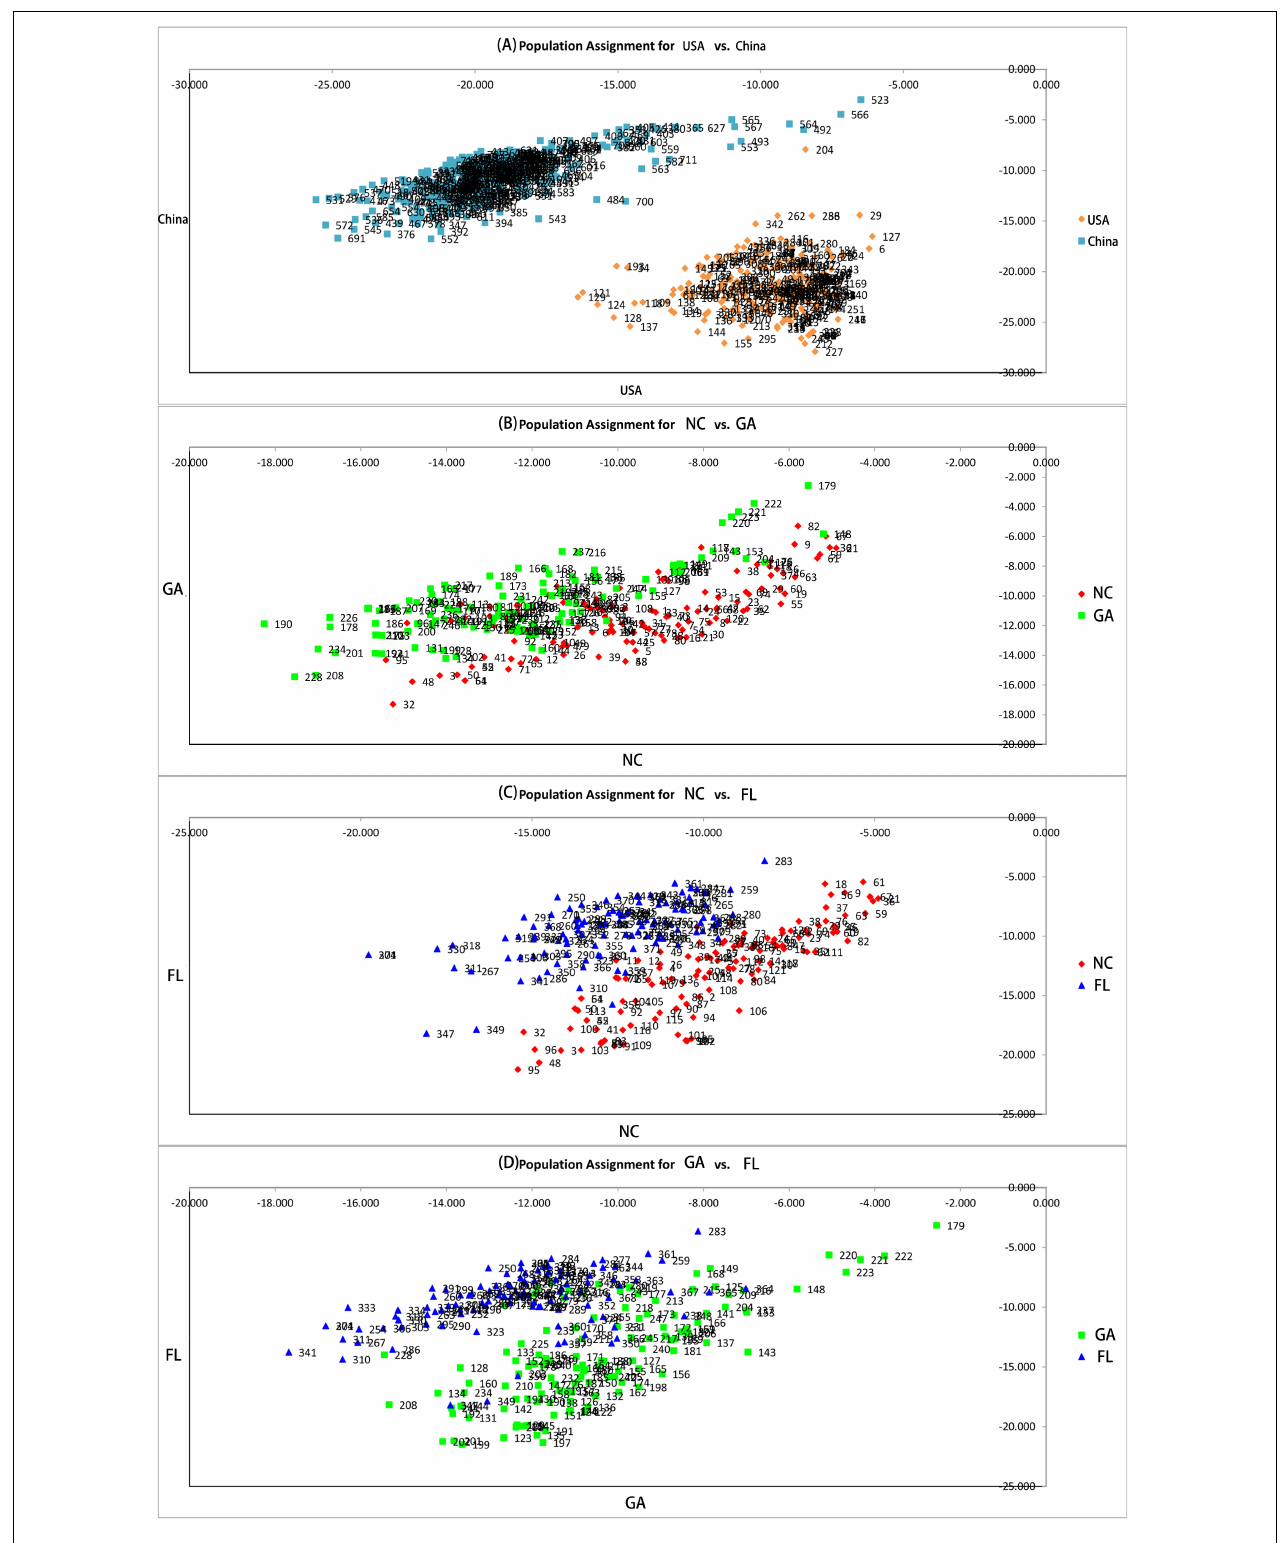
FIGURE 2 | Pairwise population assignment. (A) Pairwise population assignment between American and Chinese populations of Spartina alterniflora . (B) Pairwise population assignment between populations of S. alterniflora in North Carolina and Georgia. (C) Pairwise population assignment between populations of S. alterniflora in North Carolina and Florida. (D) Pairwise population assignment between populations of S. alterniflora in Georgia and Florida.